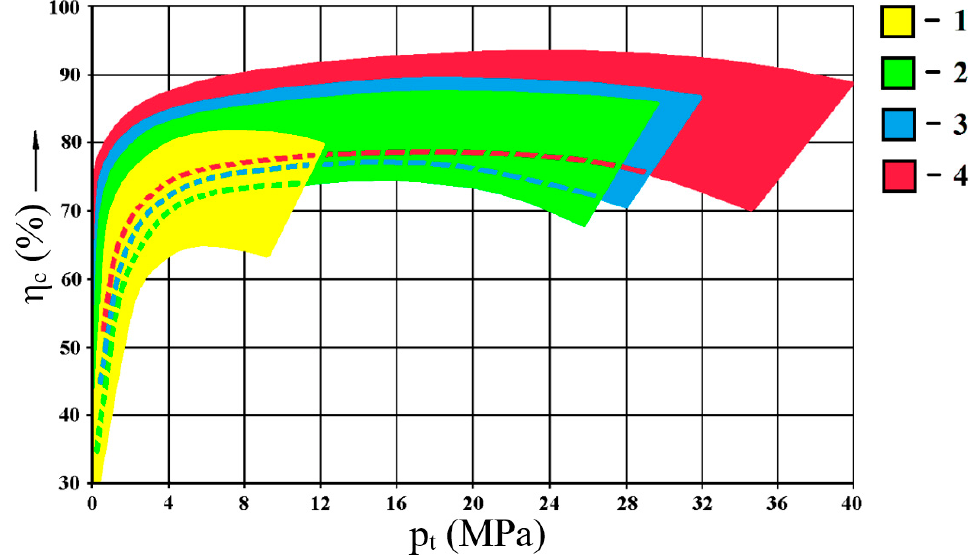
Figure 2. Total efficiencies η c of gear pumps as a function of discharge pressure p t and backlash compensation (based on technical data provided by major manufacturers and on own research): 1—no compensation, 2—with axial compensation, 3—with axial and radial compensation, 4—with axial and circumferential compensation [10].